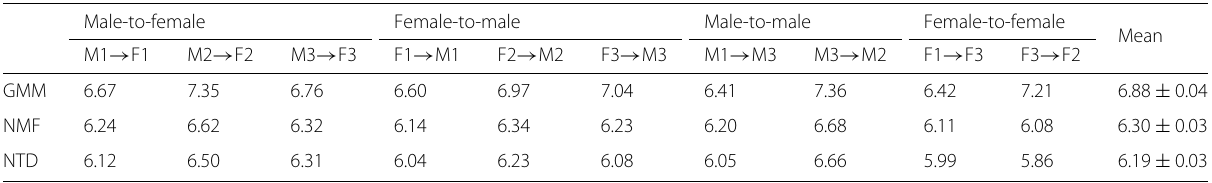
Table 2 Average MCD [dB] using parallel utterances